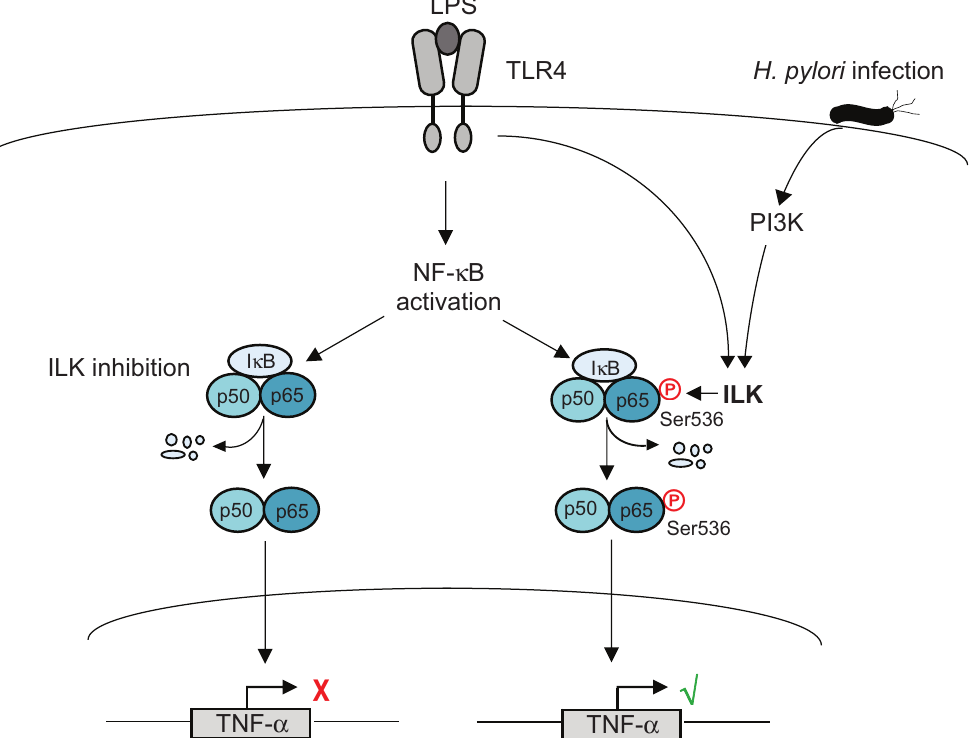
Figure 2. Integrin-linked kinase (ILK) modulates p65 Ser536 phosphorylation and tumour necrosis factor alpha (TNF-(cid:3)) production in response to LPS and H. pylori infection. For H. pylori infection, the ILK-mediated role is PI3K dependent. Inhibition of ILK (via